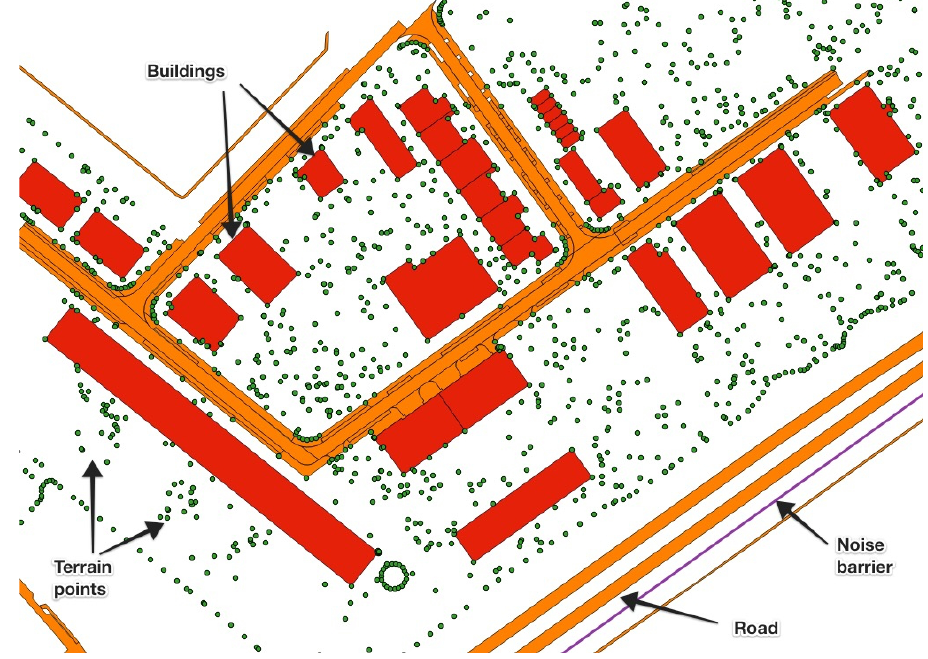
Figure 6: Generated 2.5D input model for road traffic noise